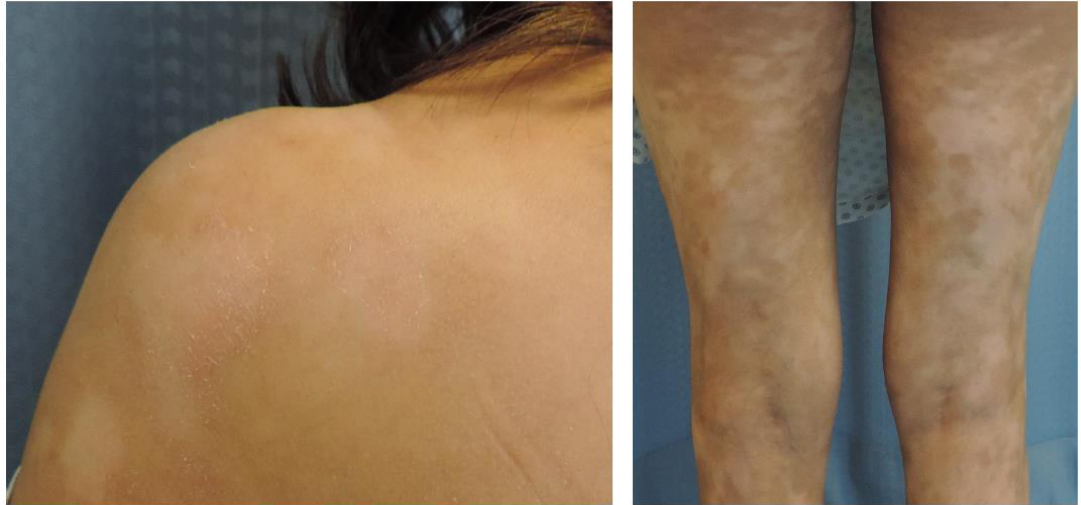
Figure 1. Clinical images of hypopigmented mycosis fungoides (HMF).